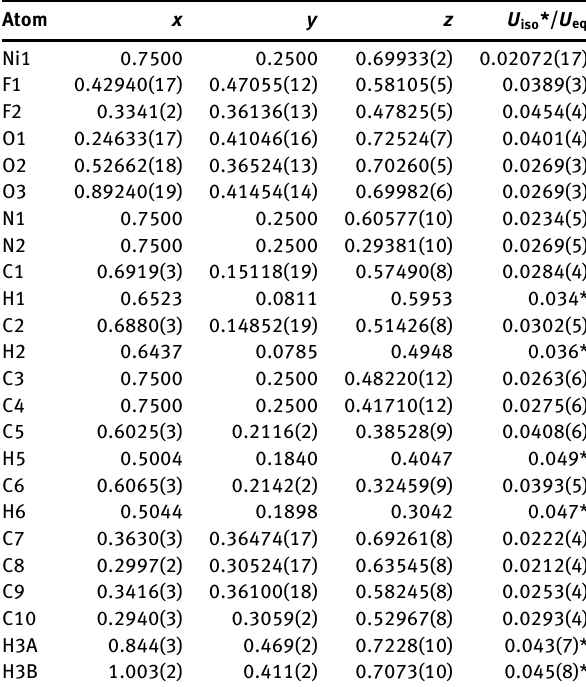
Table 2: Fractional atomic coordinates and isotropic or equivalent isotropic displacement parameters (Å 2